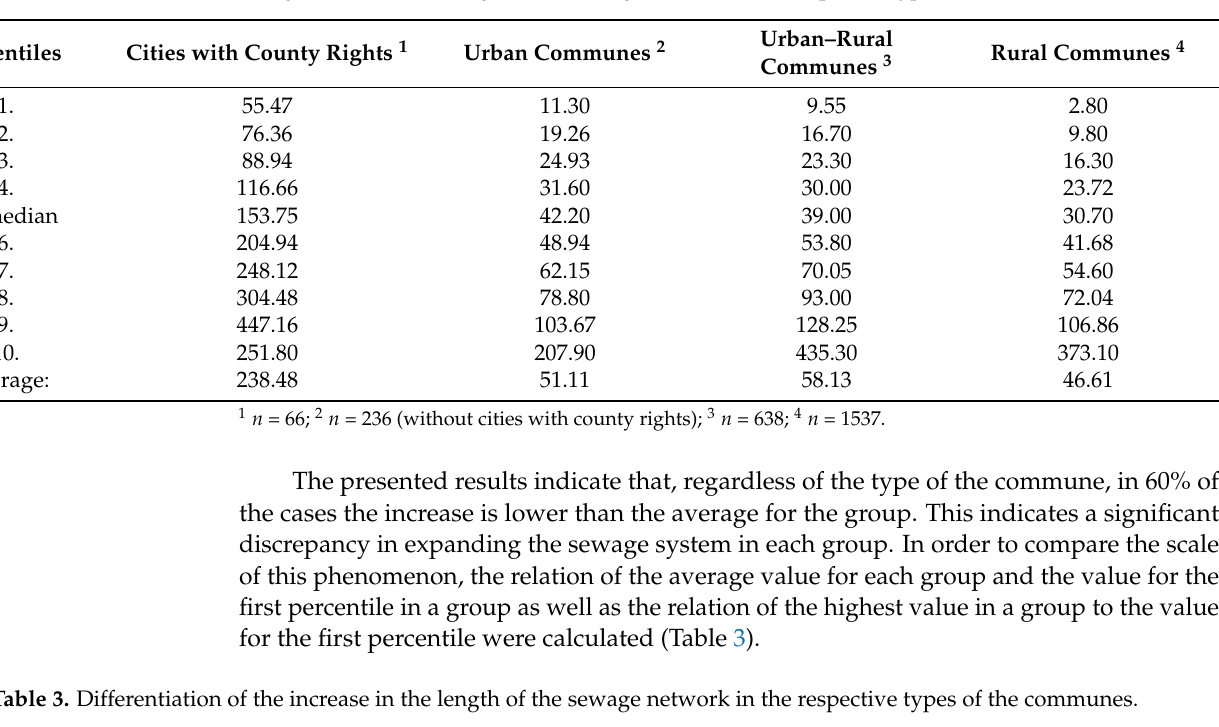
Table 3. Differentiation of the increase in the length of the sewage network in the respective types of the communes.